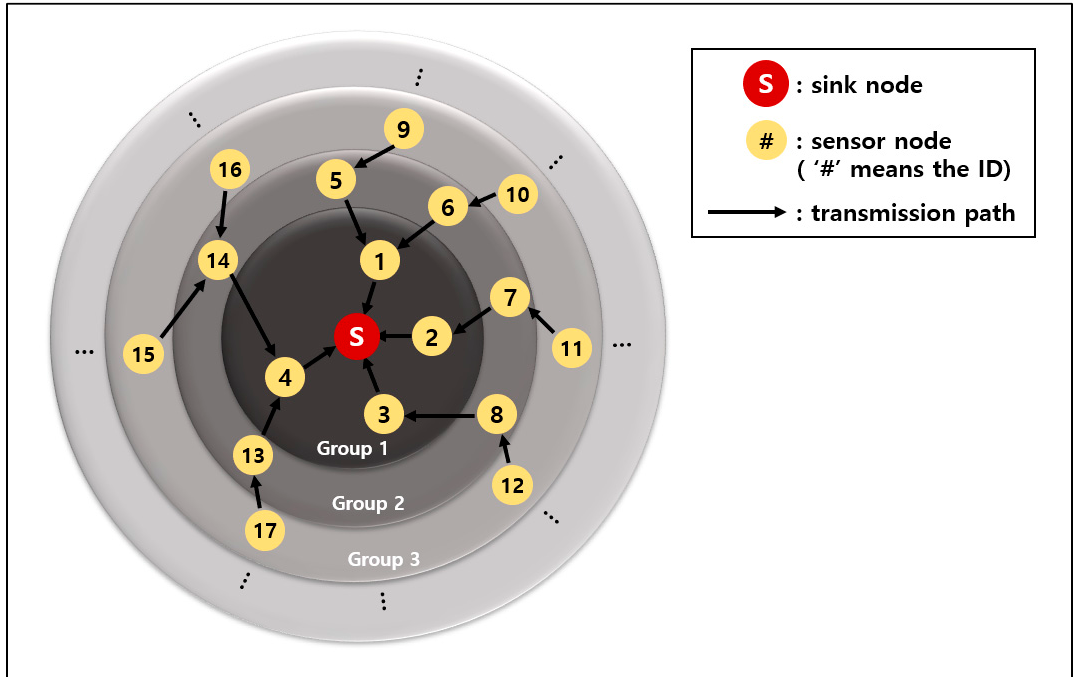
Figure 3. Initial setting of group number and data transmission path.